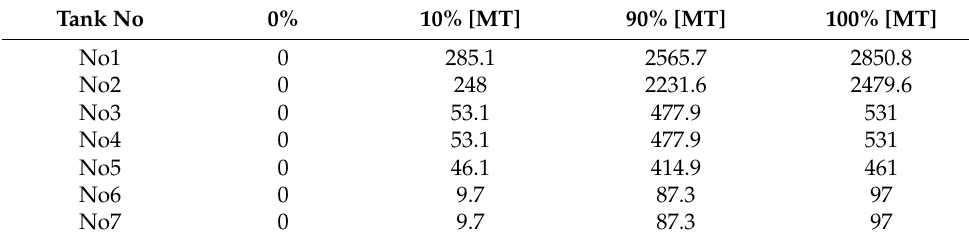
Table 4. The lower and upper filling intervals of the HFO